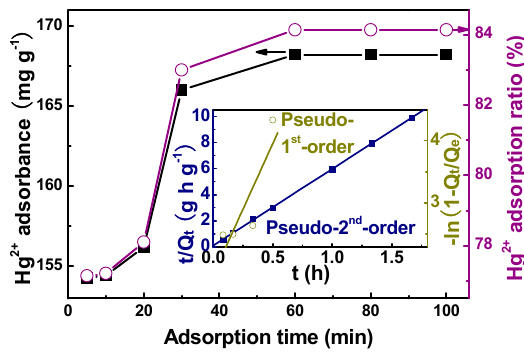
Figure 12. Adsorption kinetics of Hg 2+ ions onto PBT nanosheets. Table 4. Kinetic model equations for Hg 2+ adsorption onto PBT nanosheets.